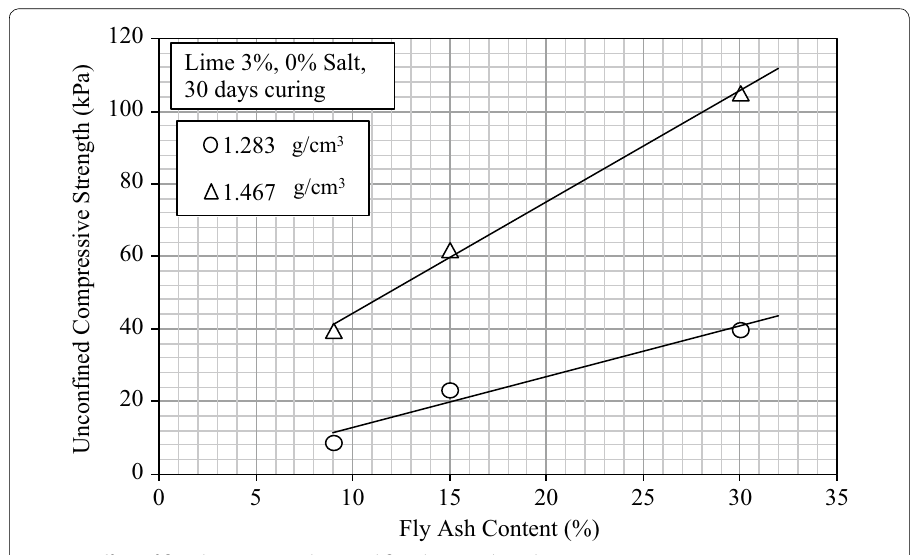
Fig. 10 Effect of fly ash content on lime and fly ash treated